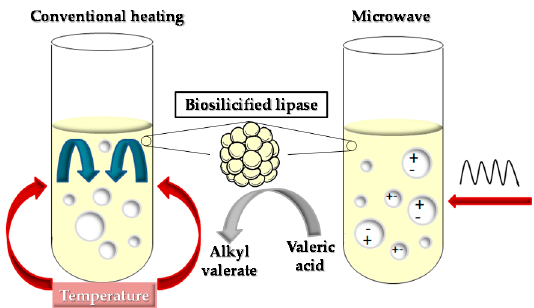
Figure 2. Conventional heating (CH) and microwave (MW)-assisted heating methodologies for the esterification of valeric acid catalysed by biosilicified enzymes.